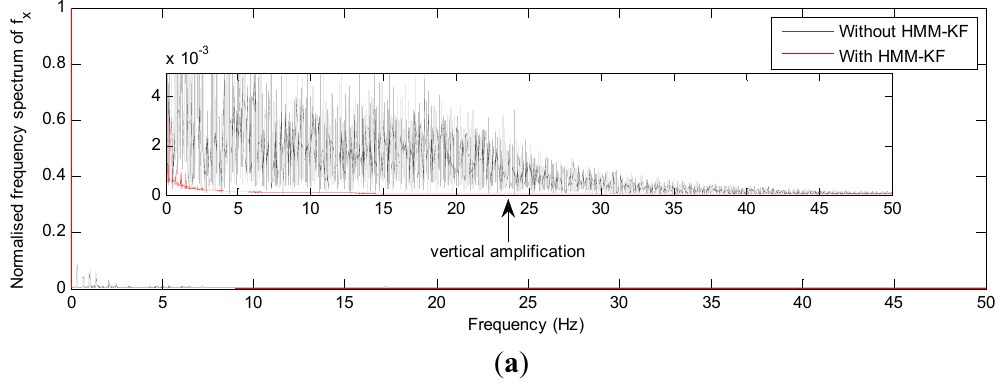
Figure 6. Frequency-domain analysis of the accelerometer outputs with and